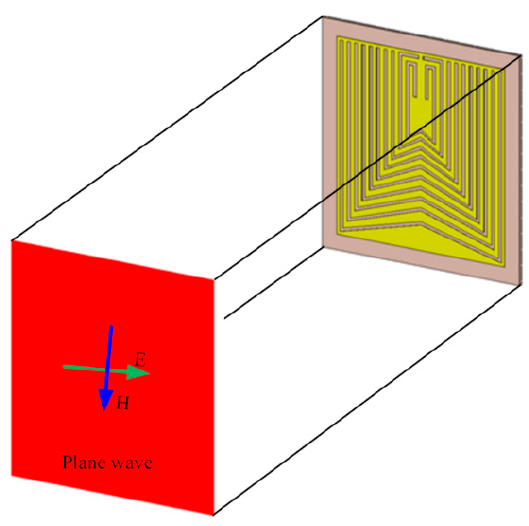
Figure 3. Simulation setup for the proposed tag.